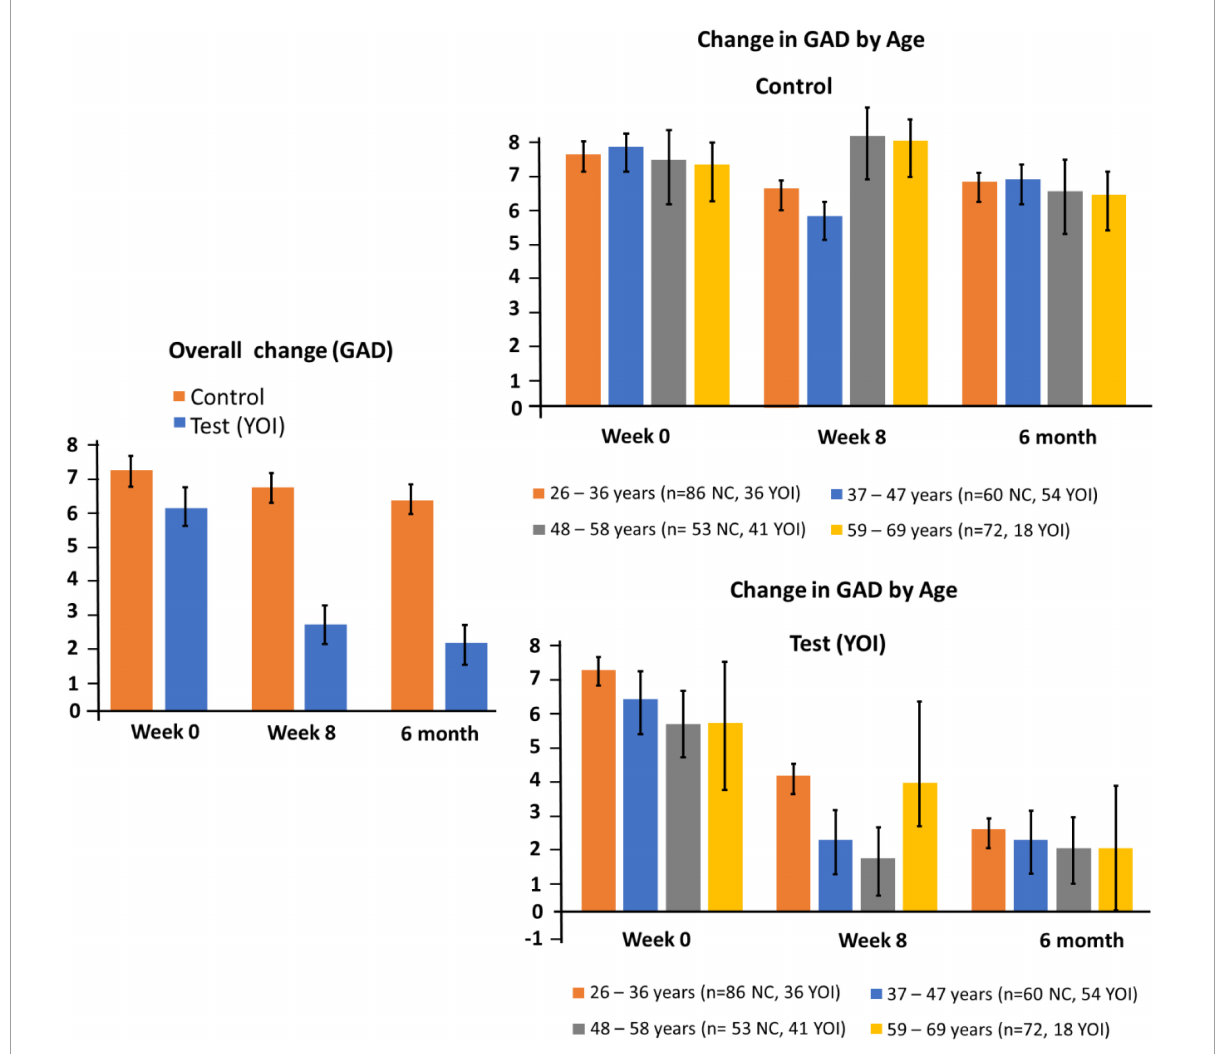
FIGURE2 Changes in GAD-7 at week 0, 8 and 20. Left panel: overall change for controls and participants. Right panel: subgroup changes by